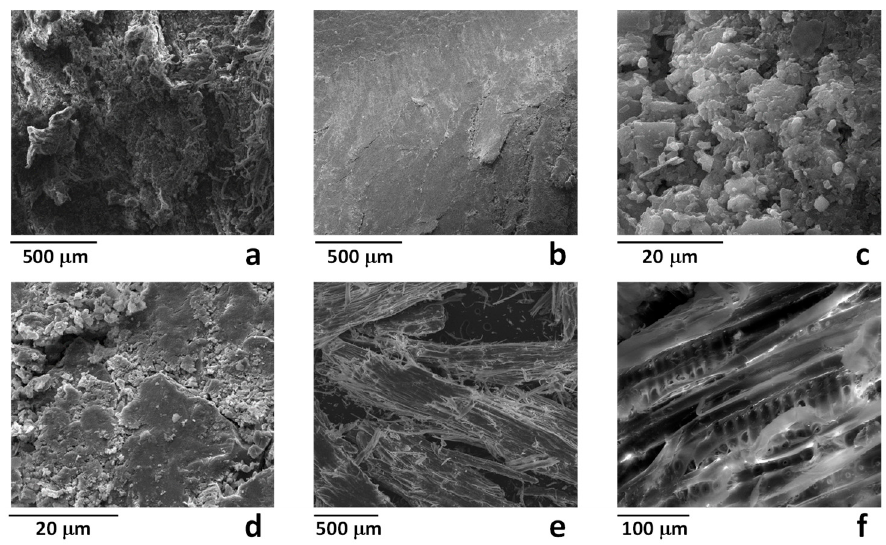
Figure 2. SEM images of the samples MBW-P1 ( a,b ) MBW-P4 ( c,d ) and MBW ( e,f ). Table 1. Results of energy dispersive X-ray (EDX) analysis (wt %) on the samples MBW-Px and MBW. Table 1. Results of energy dispersive X ‐ ray (EDX) analysis (wt %) on the samples MBW ‐ Px and MBW. Element Element